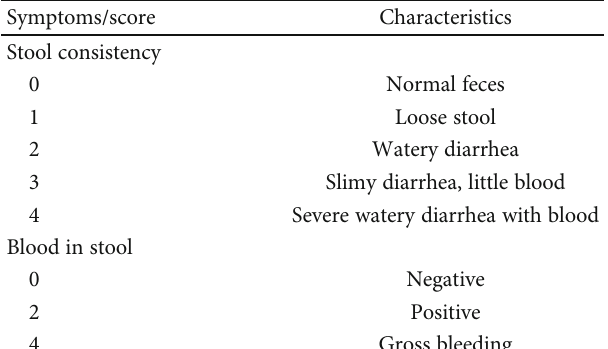
Table 6: Measurement of disease activity index using